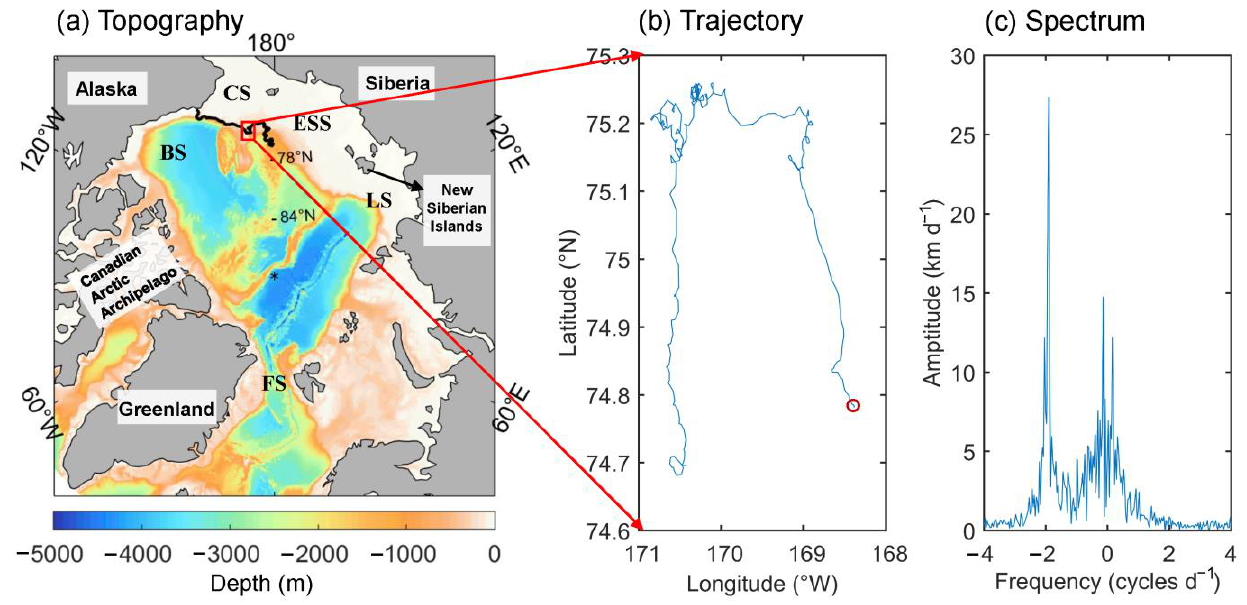
Figure 2. ( a ) Topography of the Arctic Ocean. Black curve represents the trajectory of buoy (ID: 300234067936870) in 2019. BS: Beaufort Sea; CS: Chukchi Sea; ESS: East Siberian Sea; LS: Laptev Sea; FS: Fram Strait. ( b ) The trajectory marked by the red box in ( a ) from 28th July to 26th August is magnified. The start point is marked by the red circle. ( c ) Rotary spectrum of the buoy drift velocity.